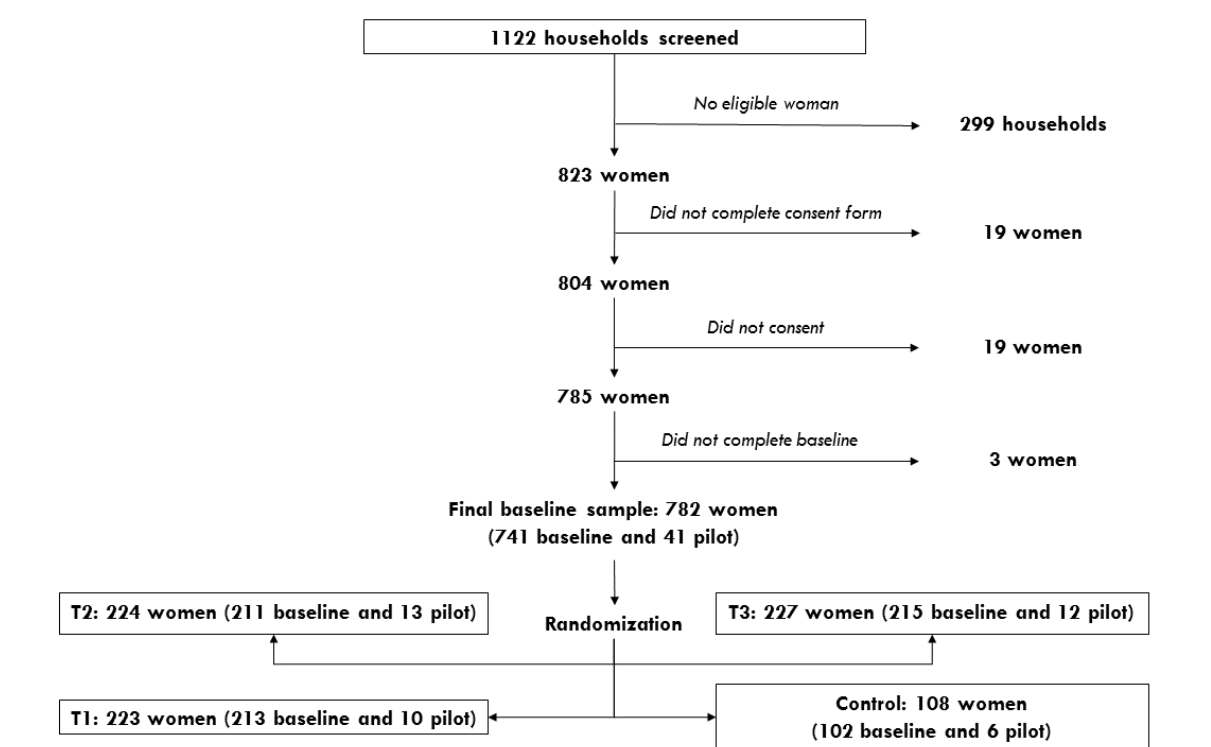
Figure 1. Experimental framework and